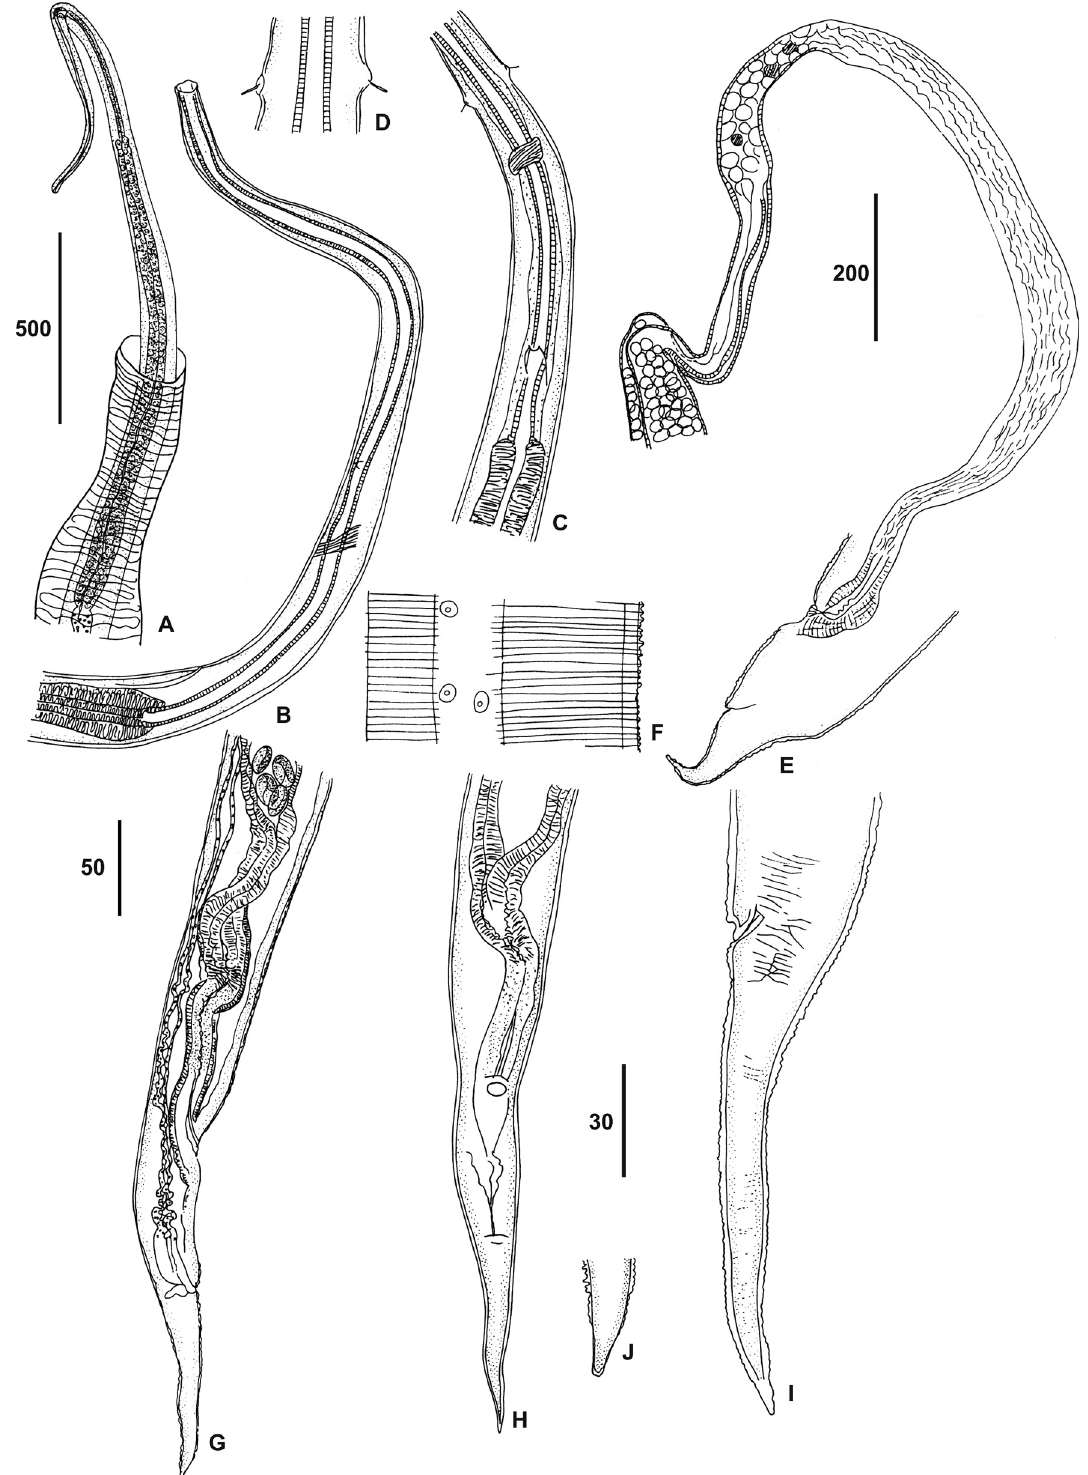
Figure 1. Trichospirura spp . females. A , T. aethiopica n. sp. Anterior region of a worm half dissected from a tube with an external muscular layer, note the anterior bend. B , part of buccal capsule and beginning of muscular oesophagus. C , detail of nerve ring, excretory pore and deirids, ventral view. D , at level of deirids, ventral view. E , T. leptostoma , posterior extremity, ovijector with a dilated chamber and uteri. F – I , T. aethiopica n. sp. F , detail of the cuticular sheath and lateral chord. G , H , posterior part, ovijector and uteri, right lateral and ventral view, respectively. I , tail, left lateral view (cuticular sheath and striae drawn at level of anus). J , caudal extremity, ventral view. Scales in l m: A, E, 500; B, C, F, I, J, 50; D, 30; G, H,